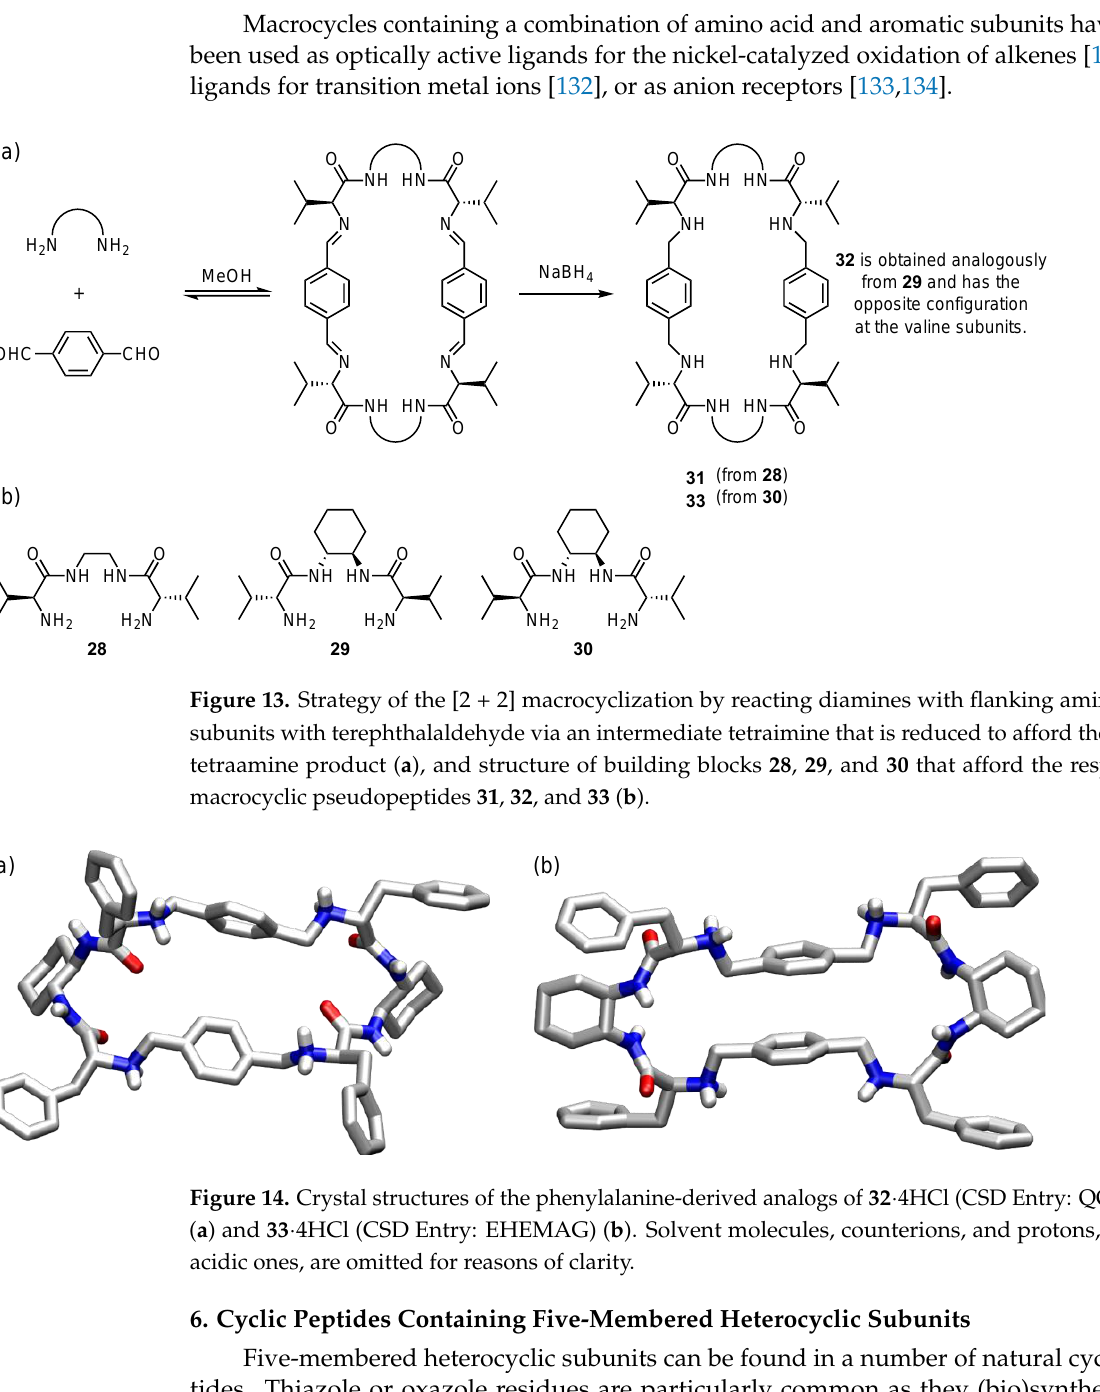
Figure 14. Crystal structures of the phenylalanine-derived analogs of 32 ·4HCl (CSD Entry: QOJREN) ( a ) and 33 ·4HCl (CSD Entry: EHEMAG) ( b ). Solvent molecules, counterions, and protons, except acidic ones, are omitted for reasons of clarity.